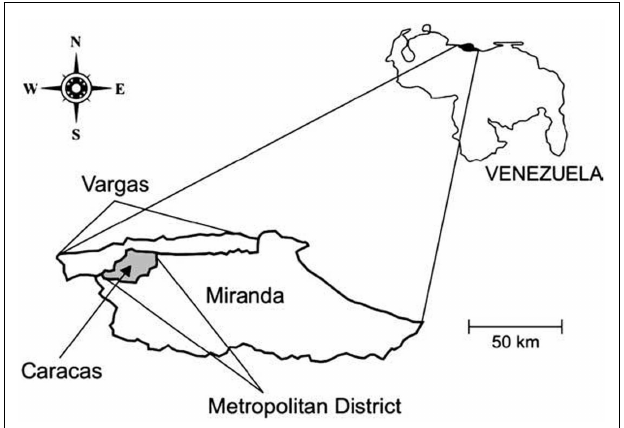
FIGURE 1 | Map ofVenezuela showing the relative location of the area of the Metropolitan District